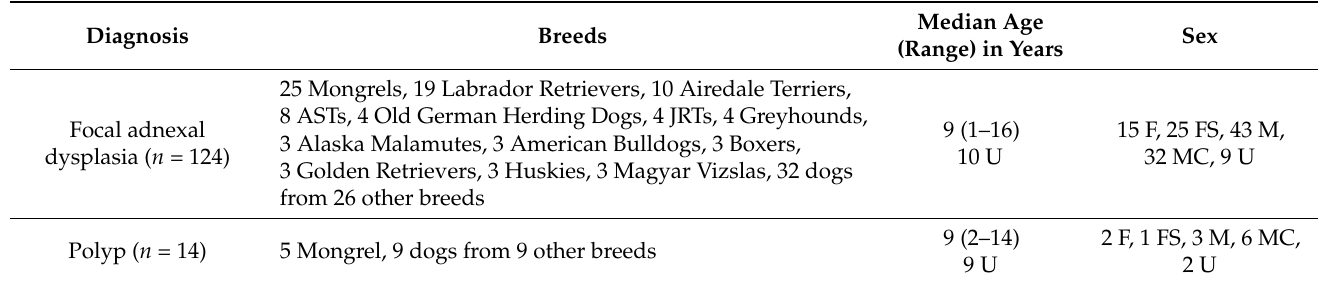
Table 2. Signalment of 138 dogs with tumor-like lesions (group 2).